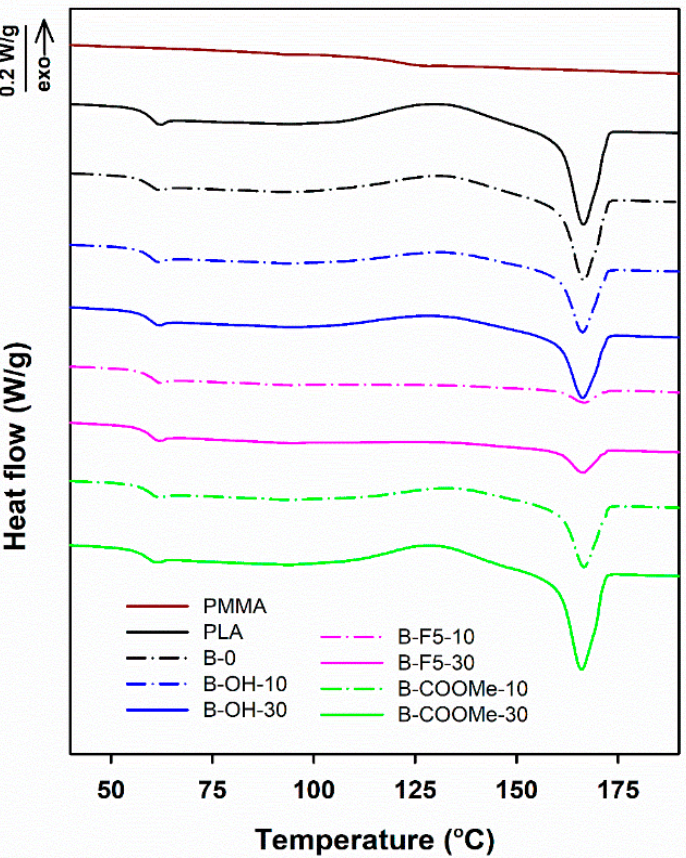
Figure 8. DSC thermograms of neat PLA, PMMA, PLA/PMMA and PLA/PMMA blends modified with LPSQ-R recorded during the second heating at 5 °C min − 1 .